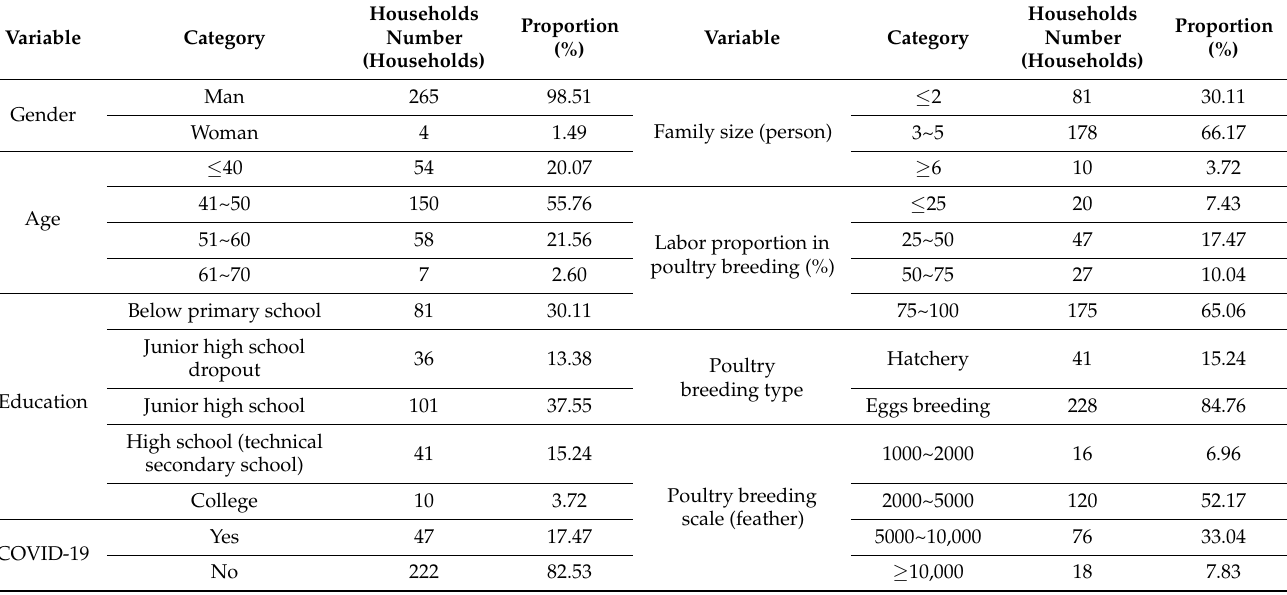
Table 2. The sample’s basic characteristics.